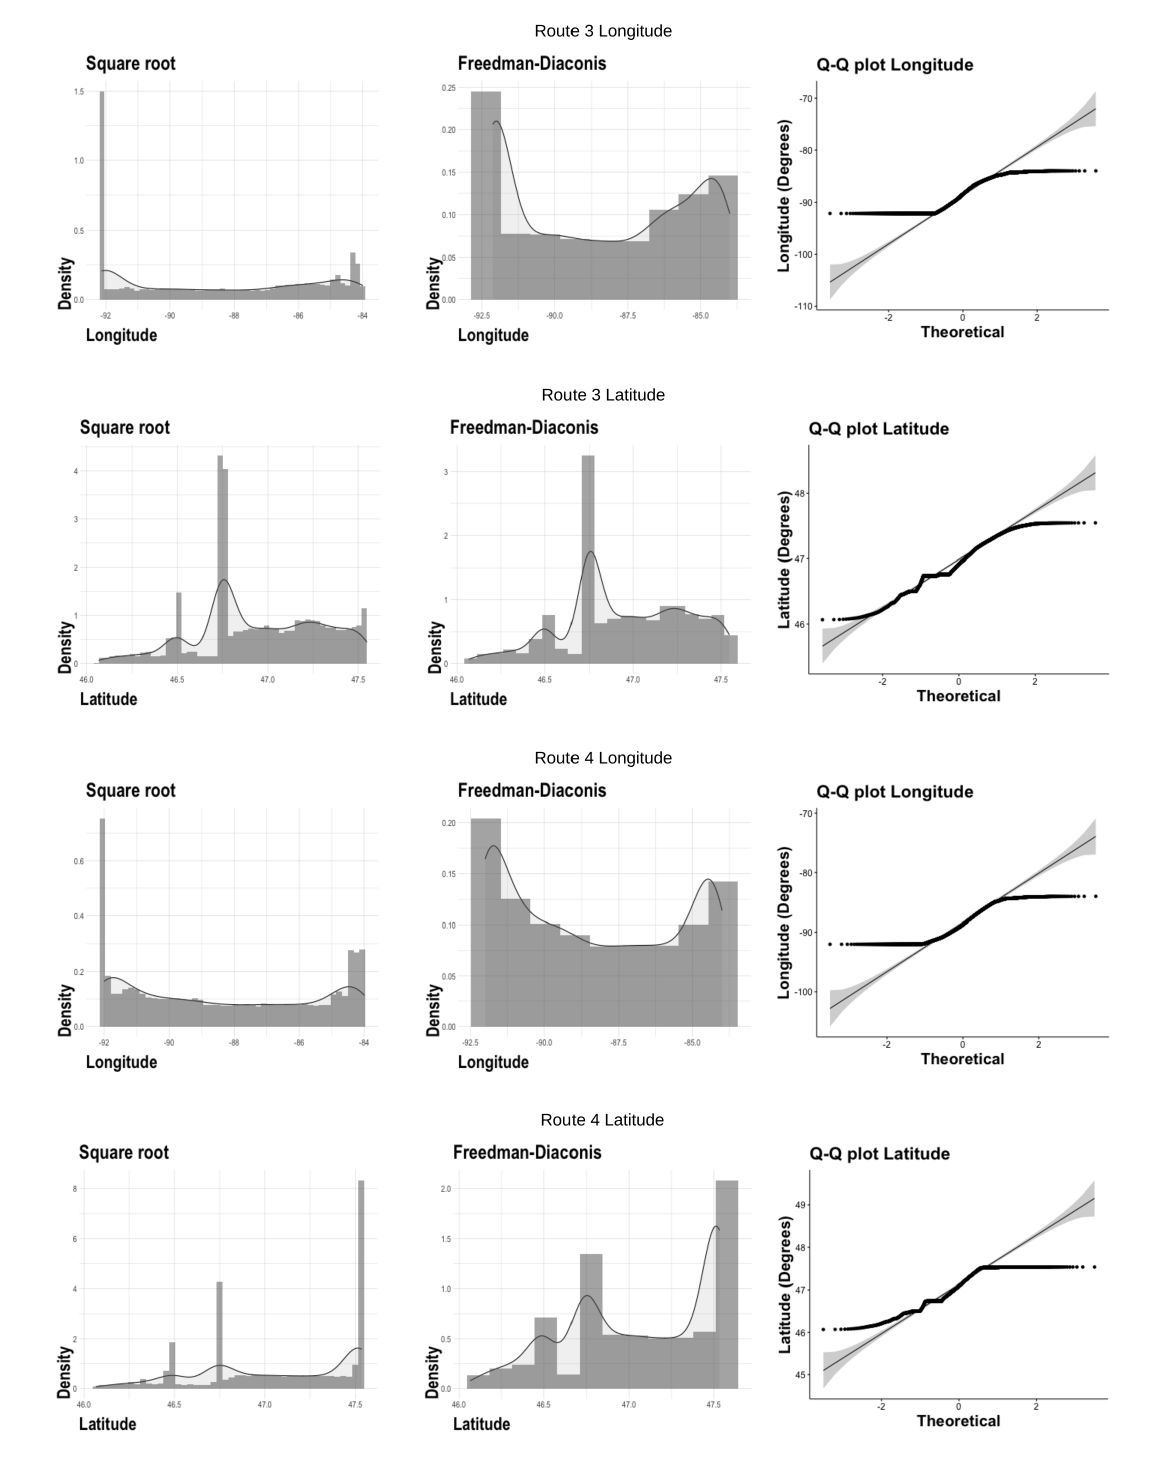
Figure 4. Route 3 and 4 Kernel Density Estimation (KDE) and histograms for each sample route to visualize the differences. Freedman–Diaconis rule is used as a complement of Figure